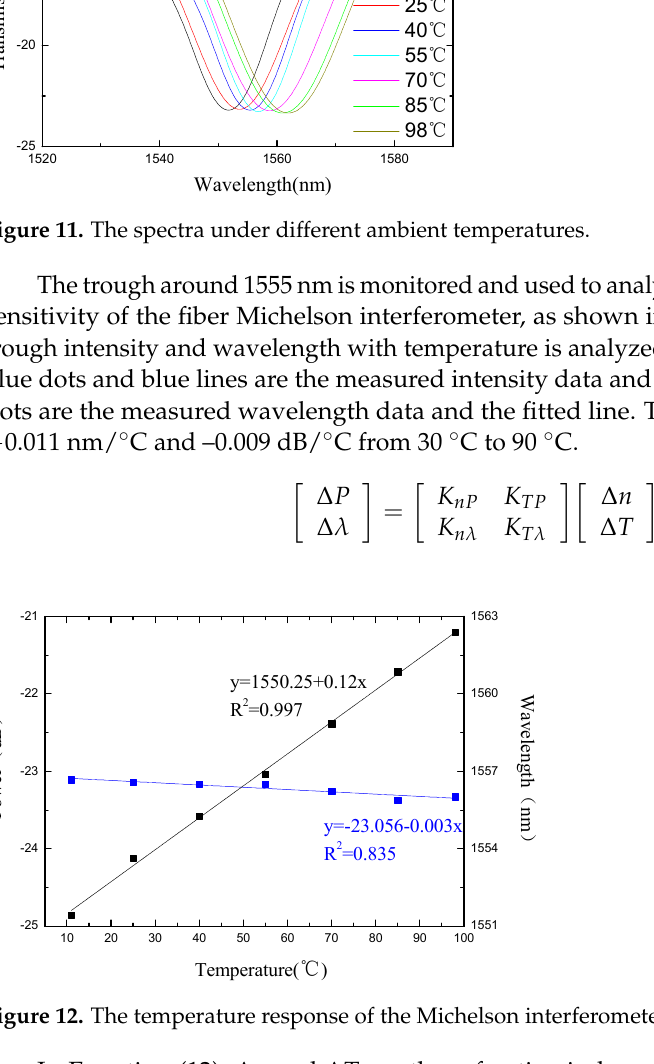
12. The blue dots and blue lines are the measured intensity data and the fitted line, and the black dots are the measured wavelength data and the fitted line. Temperature sensi- tivities are − 0.011 nm/°C and –0.009 dB/°C from 30 °C to 90 °C.